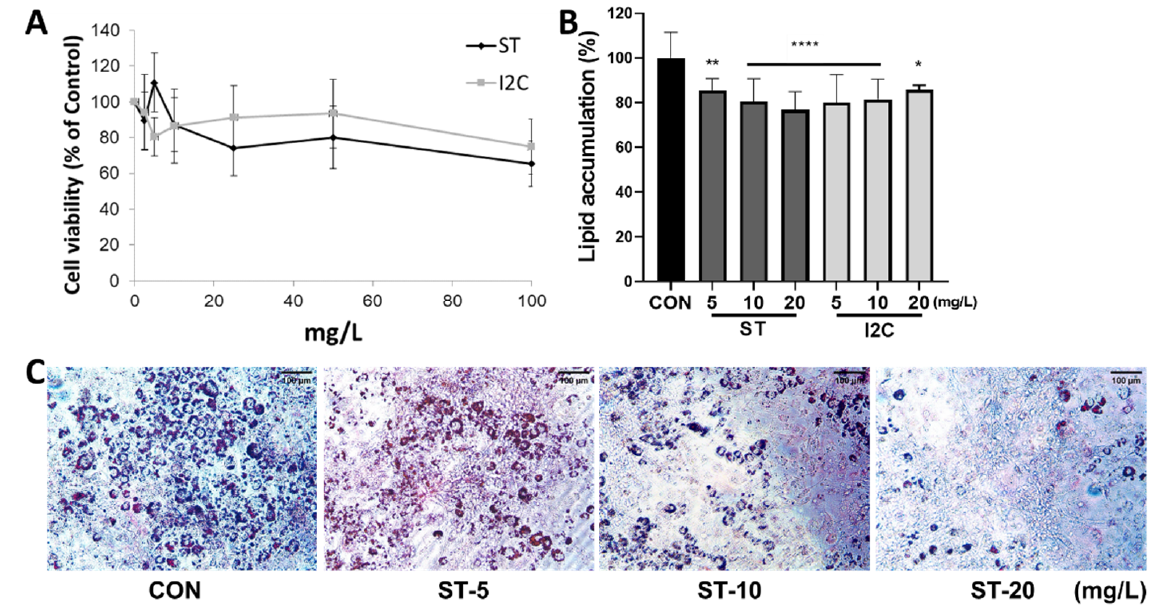
Figure 2. Effects of S. thunbergii (ST) extract and indole-2-carboxaldehyde (I2C) on cell viability and Oil Red O staining in 3T3-L1 cells. ( A ) Pre-adipocytes were treated with 0–100 mg/L of S. thunbergii and indole-2-carboxaldehyde for 48 h, and viability was determined using the MTS assay. ( B ) 3T3-L1 cells were induced to differentiation in the presence of S. thunbergii extract and indole-2-carboxaldehyde (0–20 mg/L) for 10 days. Extracted Oil Red O was quantified at OD 500 nm. ( C ) Representative images of Oil Red O staining. All data are presented as means ± SD (n = 8). Compared with the CON treatment, * p < 0.05, ** p < 0.01, **** p < 0.0001 by one way ANOVA followed by Dunnett’s test.